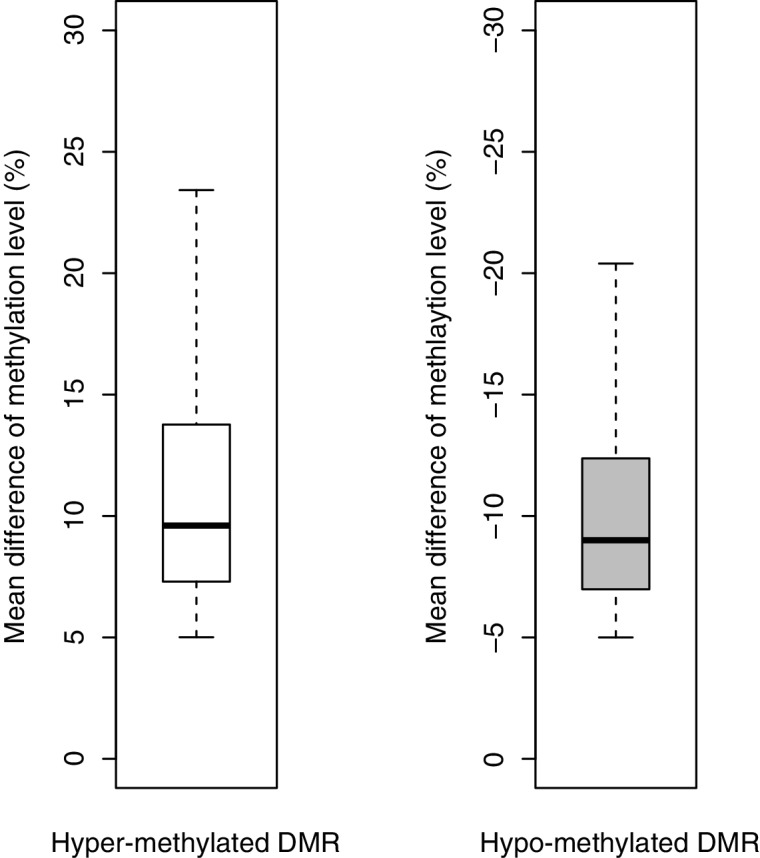
Average changes in DNA methylation in hyper- and hypomethylated DMRs.Methylation changes in hyper- and hypomethylated DMRs identified in Fam60a-/- embryos are shown by box plots. Average changes in DNA methylation were 11.87 and 10.99% for hyper- and hypomethylated DMRs, respectively.